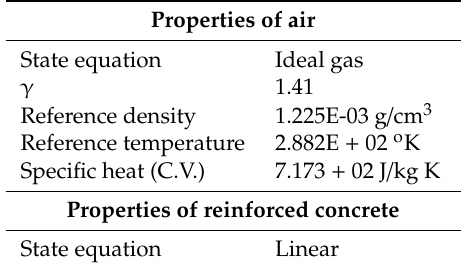
Table 1. Properties of material used in ANSYS AUTODYN.